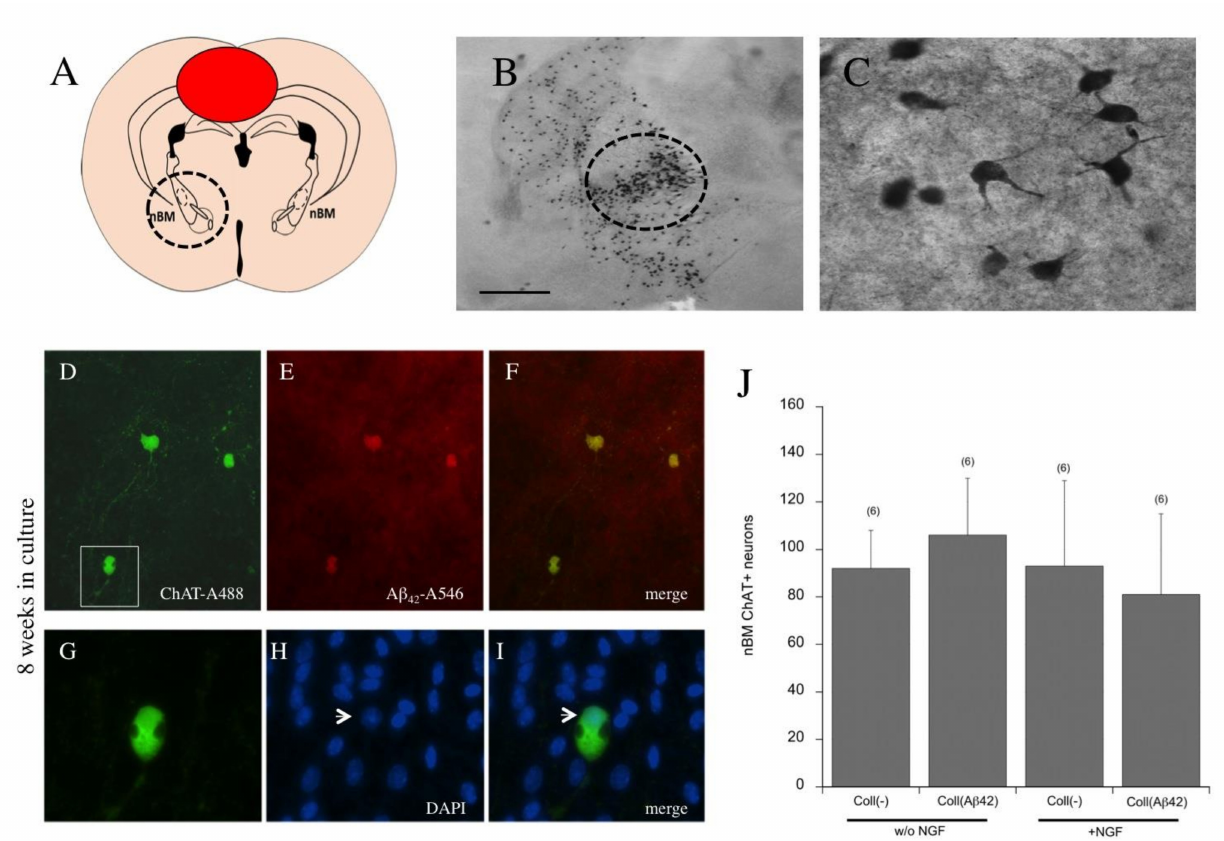
Figure 11. Effects of beta-amyloid spreading on cholinergic neurons. Brain slices of the basal nucleus of Meynert (nBM) were prepared and a collagen hydrogel loaded without or with human-beta-amyloid-42 was placed into the cortex ( A , red) and after eight weeks of incubation with or without nerve growth factor (NGF) the cholinergic neurons were stained for choline acetyltransferase (ChAT) and counted. Cholinergic neurons were counted in the nBM (see circles in A,B ) and showed a strong neuronal staining with nerve fibers ( C ). Co-localization experiments showed cytoplasmic staining of ChAT ( G , green) in DAPI+ neurons ( H , blue) in the merged picture ( I ). Co-localization showed that beta-amyloid (Alexa546, red, E ) appeared as a diffuse staining around the cholinergic neurons (Alexa488, green, D ), as shown in the merged picture ( F ). The white square (in ( D) ) shows a magnification of ( G – I ). Quantitative analysis shows that application of hA β 42 onto the brain slices did not markedly affect the survival of cholinergic neurons, neither when cultured with nor without (w/o) NGF ( J ). Statistical analysis was performed by one-way ANOVA and Fisher LSD post hoc test. Values are given as means ± SEM; values in parenthesis give the number of analyzed mice. Scale bar in B = 180 µ m ( B ), 70 µ m ( C ), 90 µ m ( D – F ) and 25 µ m ( G – I